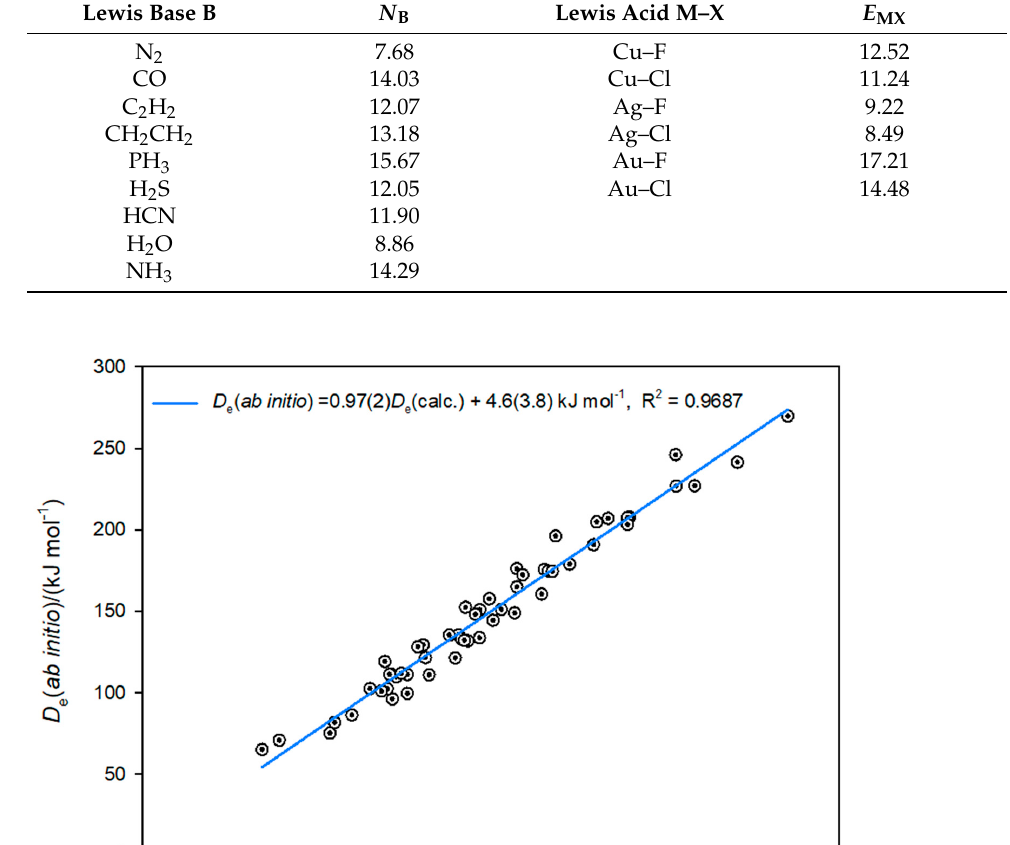
Figure 3. D e plotted against N B for each series B···CuF, B···CuCl, B···AgF, B···AgCl, B···AuF, and B···AuCl, where B = N 2 , CO, C 2 H 2 , C 2 H 4 , PH 3 , H 2 S, HCN, H 2 O, and NH 3 . Each straight line is a linear regression fit to the set of points for the associated B···M–X.